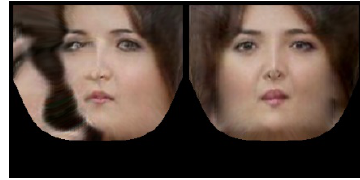
Figure 8. Coupled Texture Data.